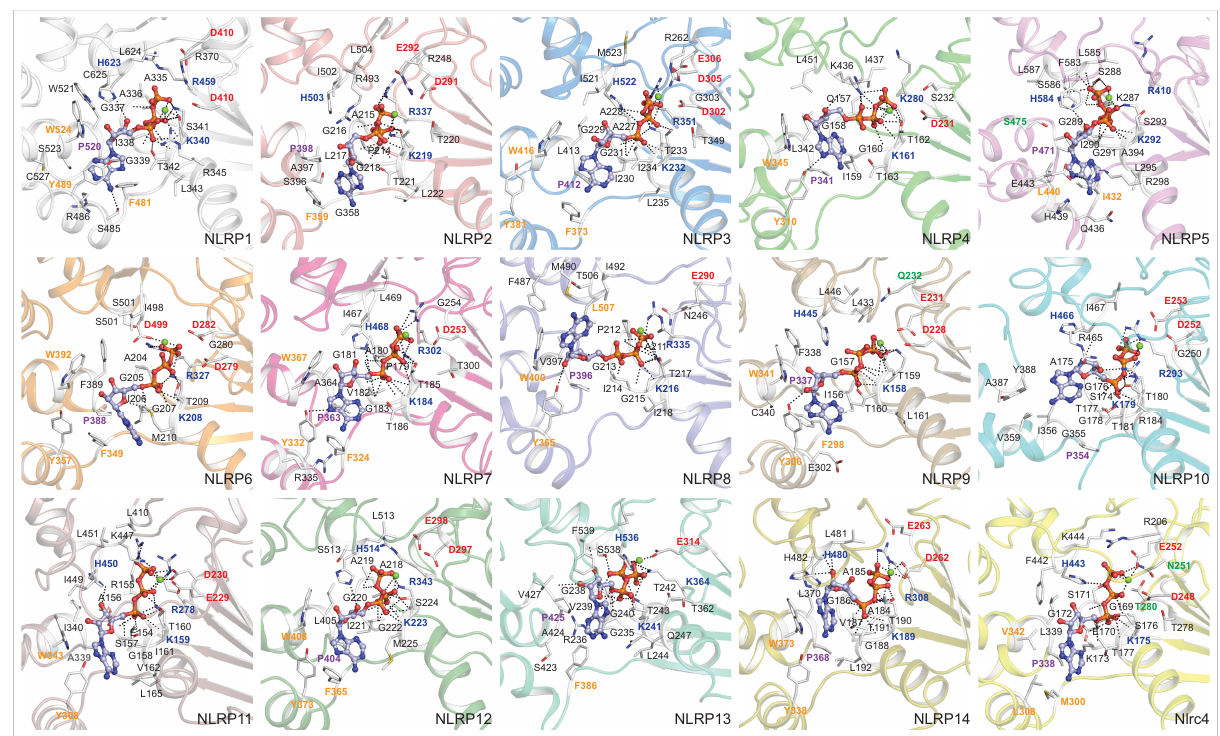
Fig 3. Overview of detailed intermolecular interactions governed by ATP and NLRP NACHT models. The NLRP NACHT models are displayed in cartoon; ATPs are visualized in light blue ball-sticks and the residues interacting within 5 Å of ATP are visualized in white stick model. The black dotted lines represent the intermolecular polar contacts. The key interacting residues (of proposed ATP-binding motifs) are presented in bold font and colored based on their physicochemical parameters.